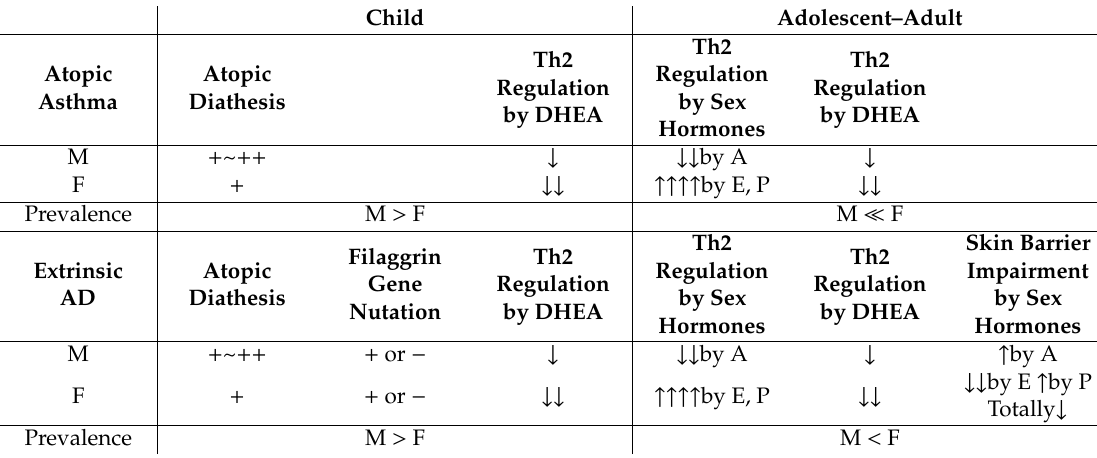
Table 6. The generation-dependent sexual di ff erence in the prevalence of atopic asthma and extrinsic atopic dermatitis